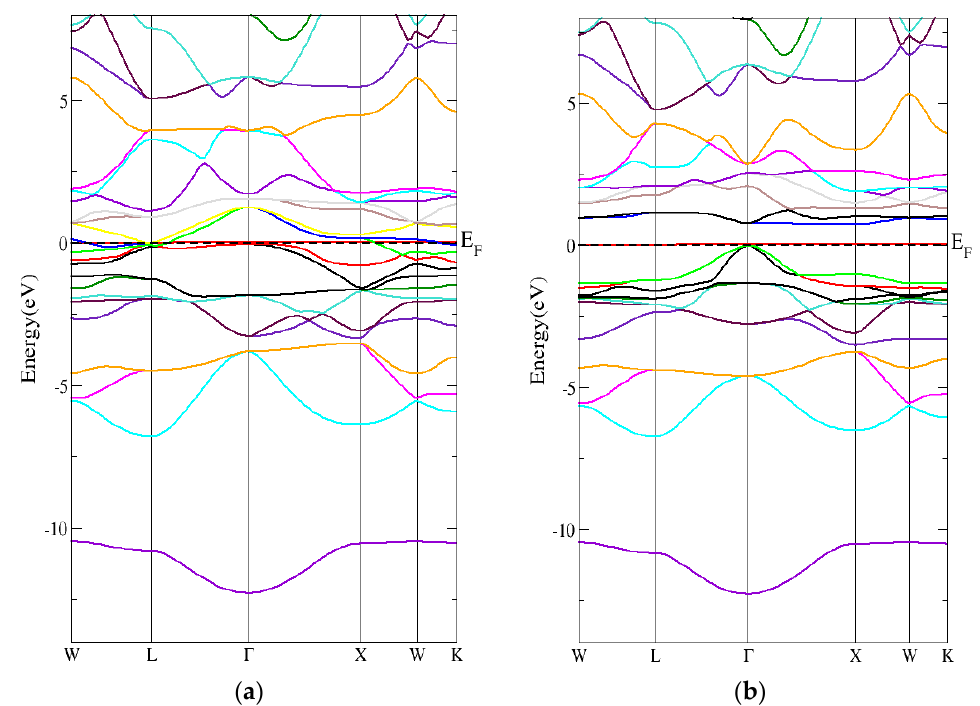
Figure 9. The band structure for the inverse Heusler Cr (cid:2870) MnSb compound by employing the mBJ– GGA technique for ( a ) spin-up inverse Heusler Cr (cid:2870) MnSb compound and ( b ) spin-down inverse Heusler Cr (cid:2870) MnSb compound. Table 6. The energy band gaps for conventional and inverse Cr (cid:2870) MnSb compound using PBE–GGA and mBJ methods.